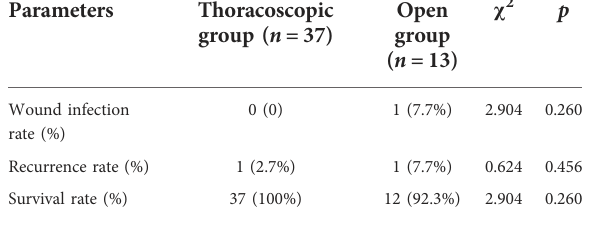
TABLE 1 Comparison of general characteristics of the two groups.